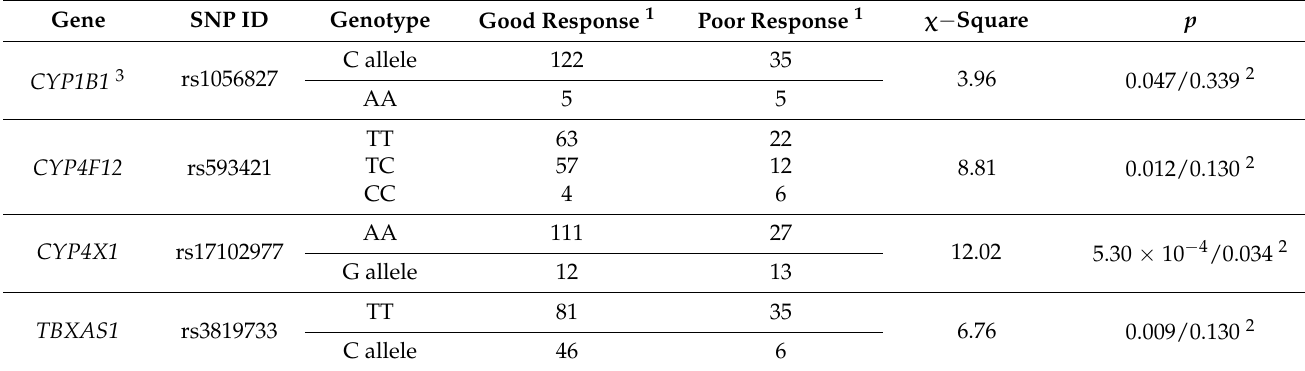
Table 4. Cytochrome P450 variants significantly associating with the response of patients to the neoadjuvant cytotoxic therapy in the confirmation set.